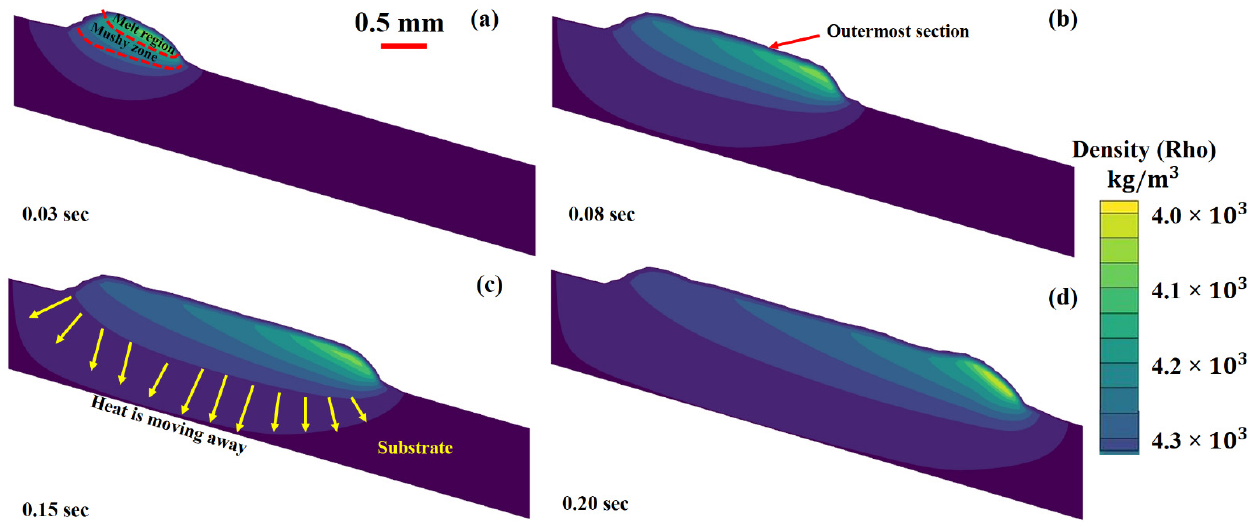
Figure 8. Cross section for the liquid to solid conversion in Ti6Al4V layer deposition at: ( a ) 0.03 s, ( b ) 0.08 s, ( c ) 0.15 s and ( d ) 0.20 s.